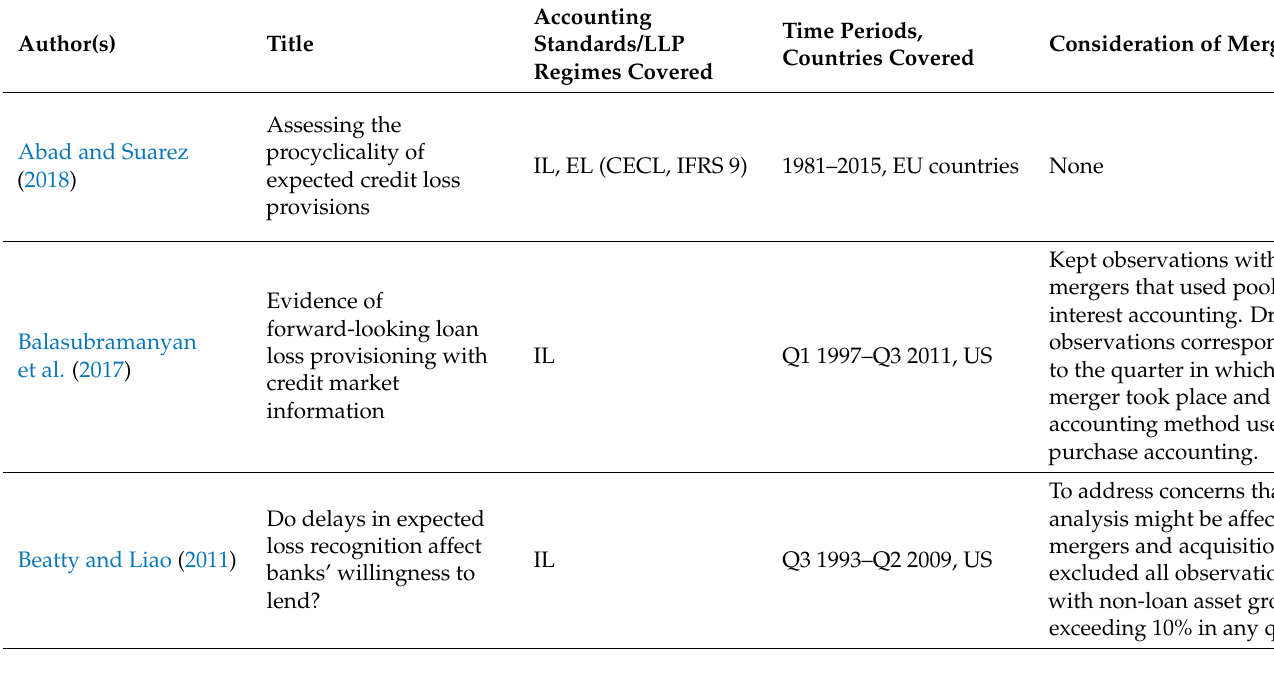
Table 1. Literature